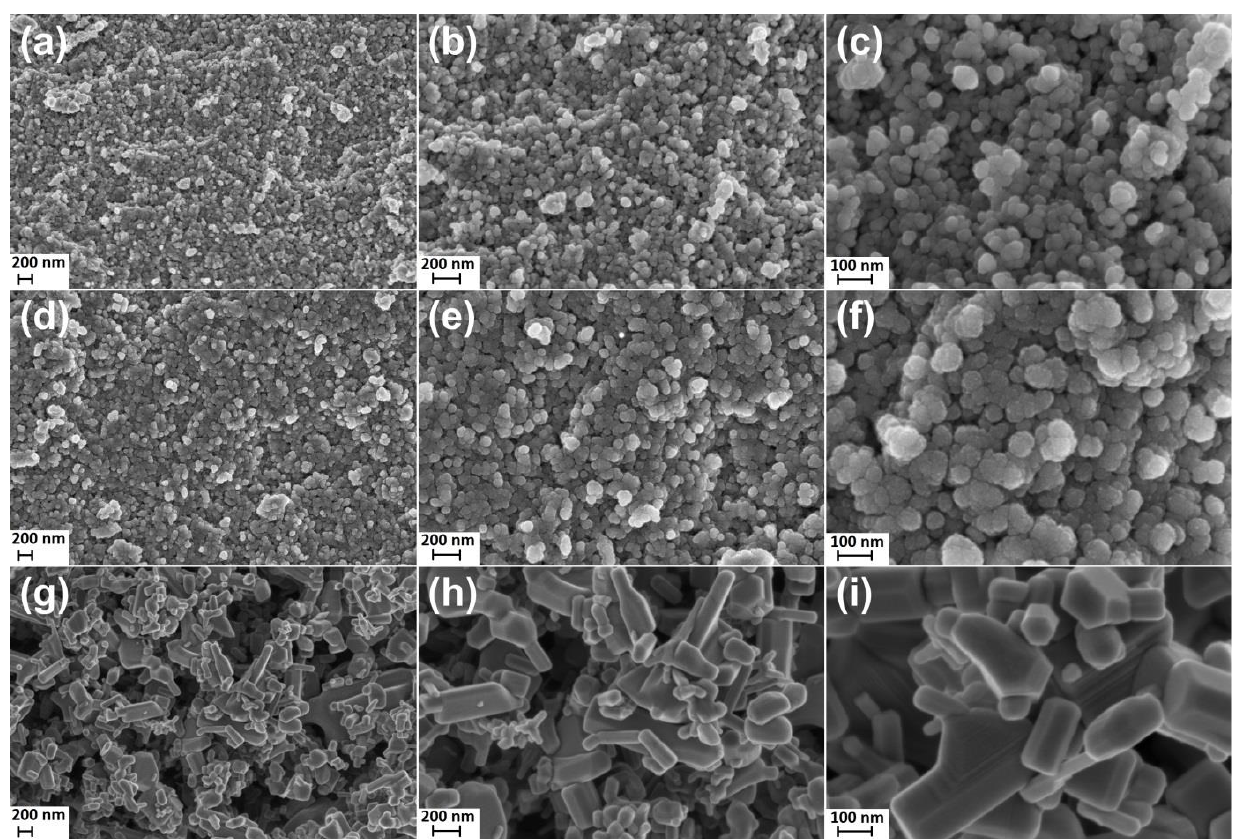
Figure 1. SEM images of samples: ( a – c ) ZnO NPs; ( d – f ) ZnO+1%Ag NPs; ( g – i ) ZnO SMPs. ( a – i ) images taken with the immersion lens detector. Image magnifications: ( a , d , g ) 50,000×; ( b , e , h ) 100,000×; ( c , f , i ) 250,000×.